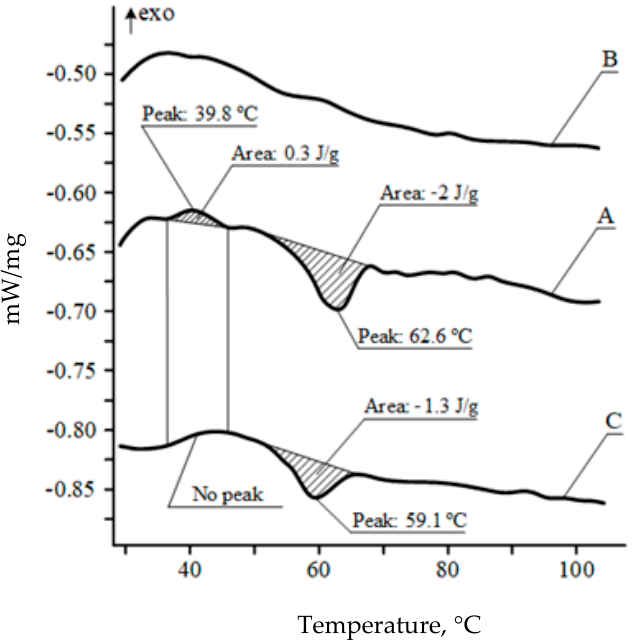
Figure 10. DSC analysis of PVC films with “shape memory”: A—”initial” film sample (1st heating), B—”initial” film sample (2nd heating), C—film sample treated at 36 ± 1 °C with 30% THF solution for 10 min.